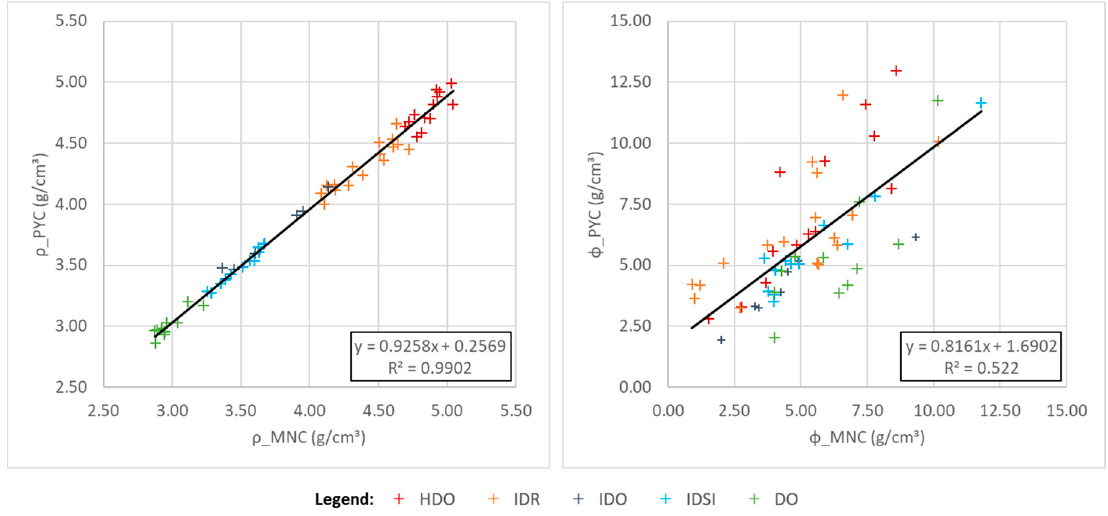
Figure 4. Scatter diagrams of mineral density ( left ) and porosity ( right ) calculated by MNC and PYC methods, using carbonate samples—data from the Table 4—(subgroup 3).